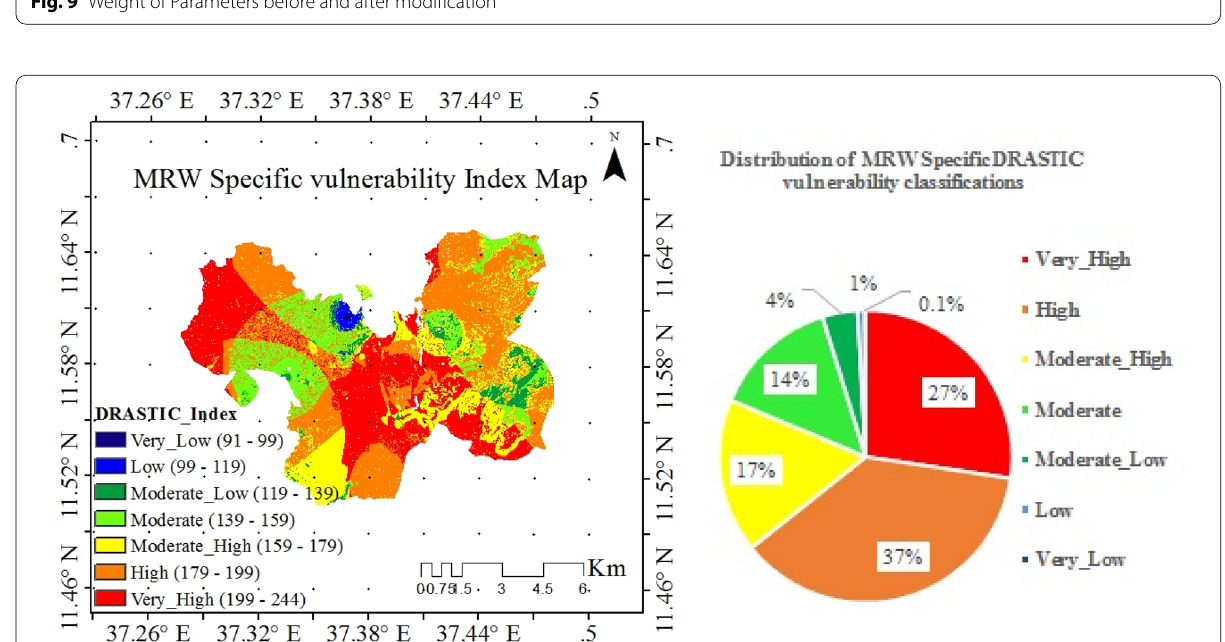
Fig. 10 Modified-rates Specific DRASTIC map (left) and area percentages